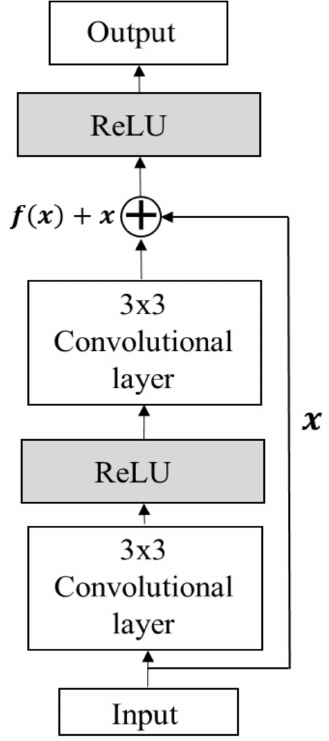
Figure 6. The architecture of ResNet [41].